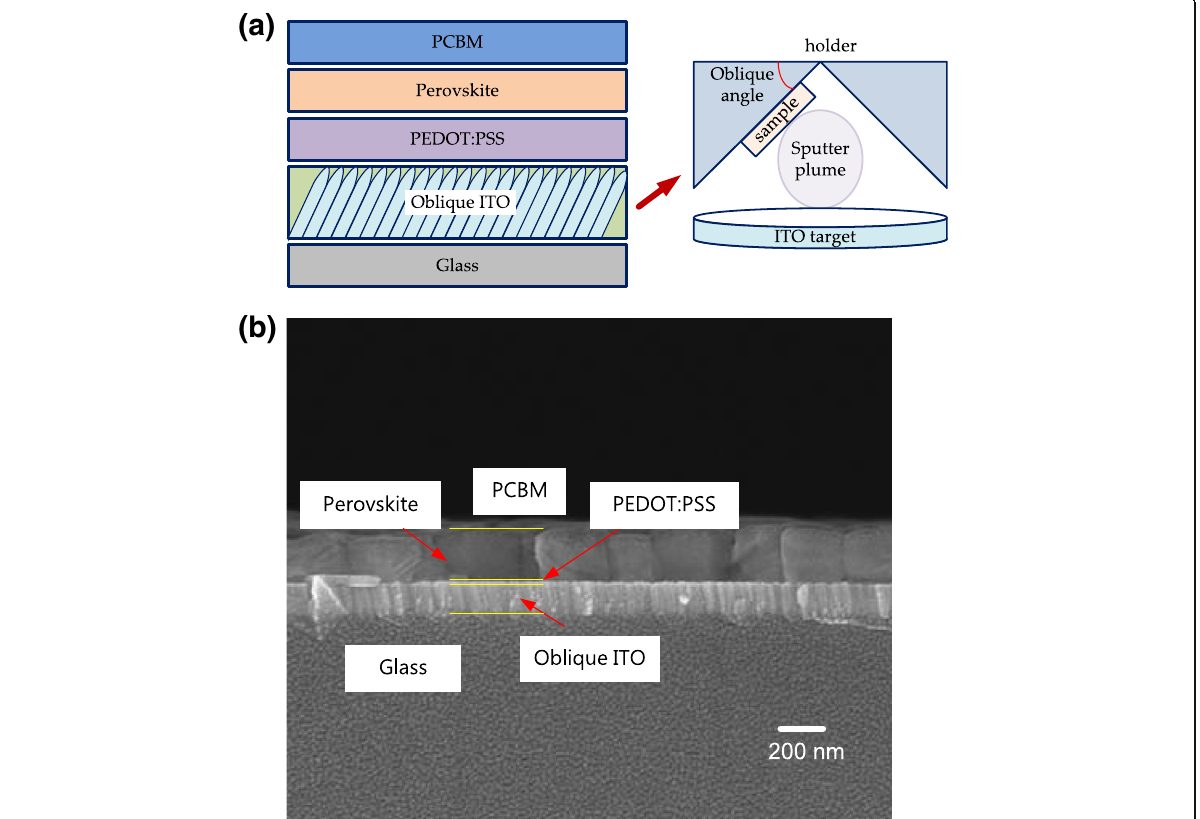
Fig. 1 a Schematic cross section of completed structure and oblique sputtering system. b Cross-sectional FESEM image of sample with 30°-tilted sputtered oblique ITO